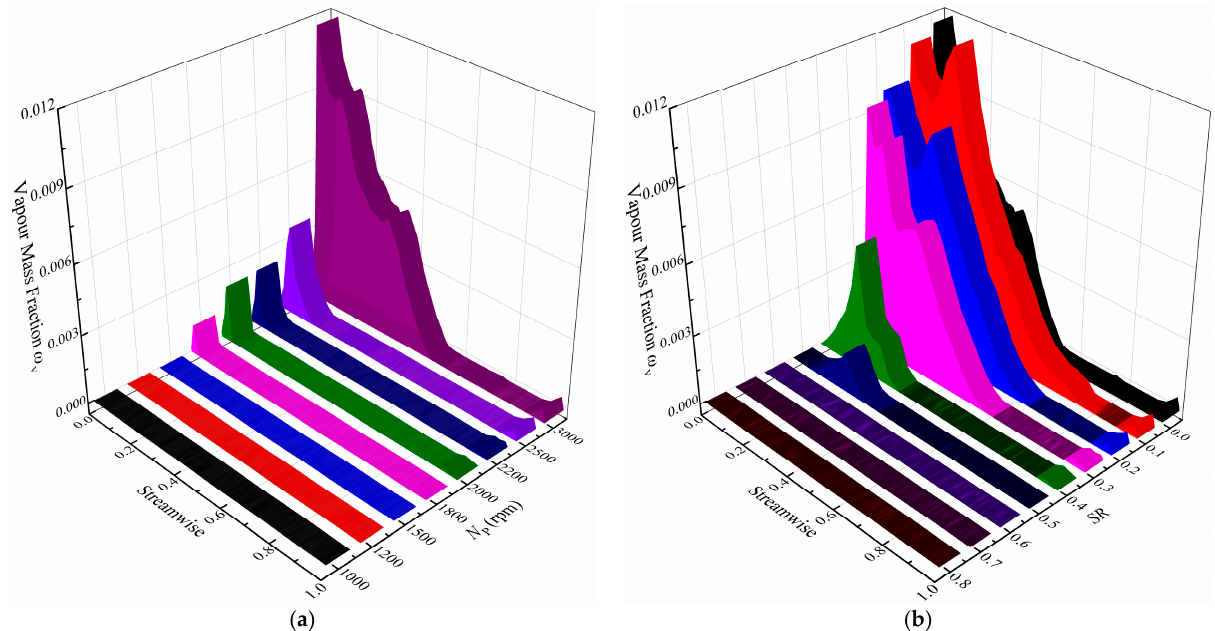
Figure 21. The vapor mass fraction on stator blade under various conditions. ( a ) Under various N P when SR = 0. ( b ) Under various SR when N P = 3000 rpm.